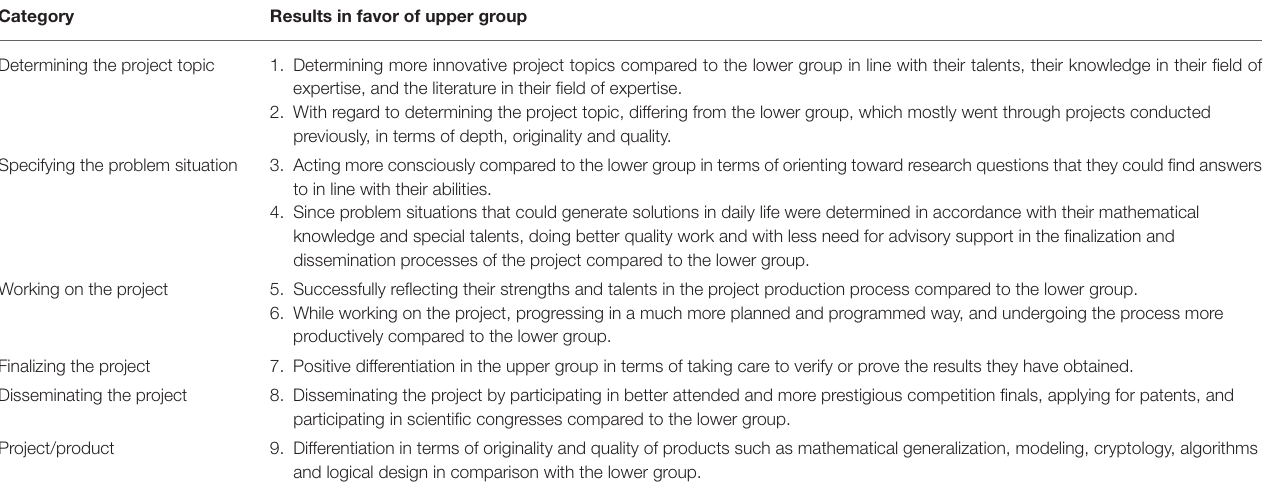
TABLE 6 | Project production and management results in favor of the upper group of gifted students.